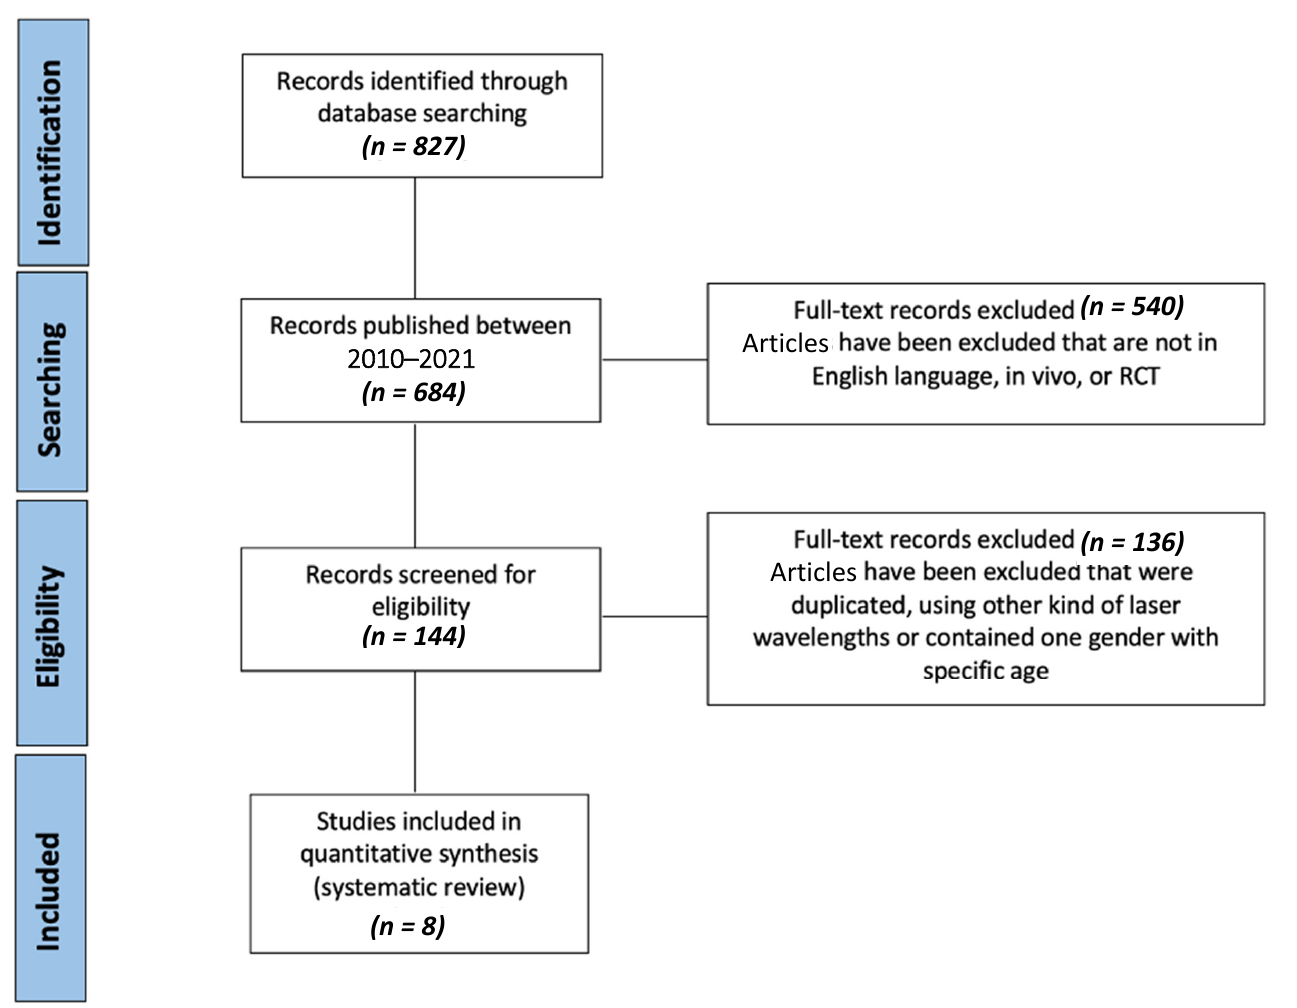
Figure 2. Flow diagram of literature search according to PRISMA guidelines.